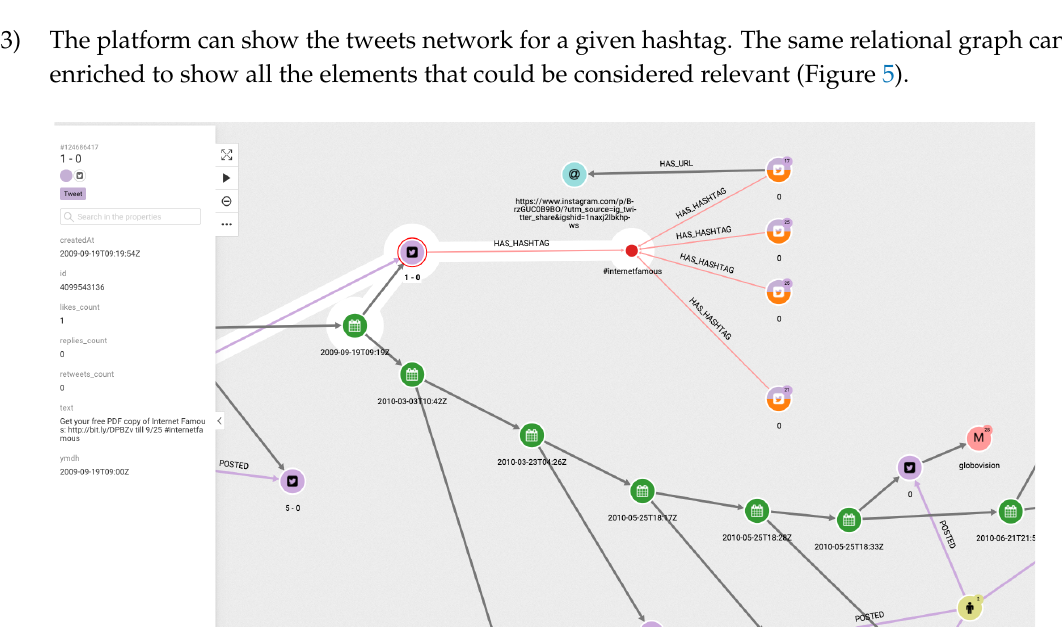
Figure 4. Analysis of tweets: relationship among users.